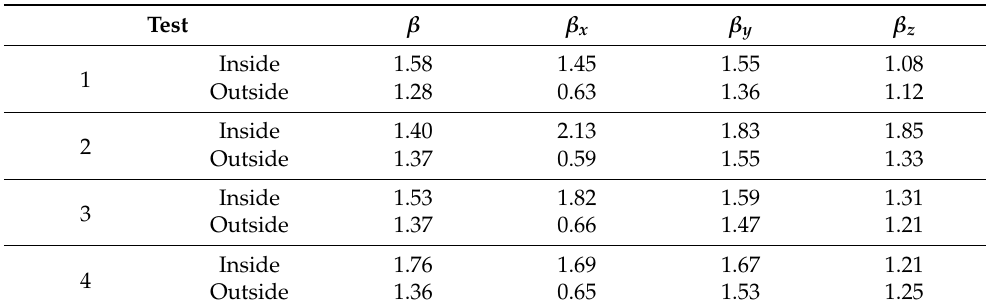
Figure 8. Energy density spectra at outer window side at the north side window (Test 1). Spectra Figure 7. Energy density spectra at the north side window (Test 1). Outer window side ( ▬ ) and of u x ▬ u y ▬ , and u z ( inner window side ( ▬ ). Table 6. Spectral decay slope β (slope in the longitudinal component, β x ; transversal component, β y ; vertical component, β z